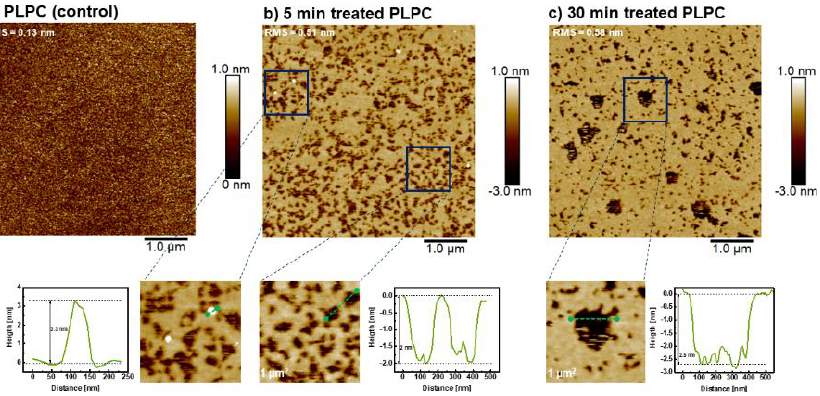
Figure 7. AFM images of supported PLPC bilayers before ( a ), after 5 min; and ( b ) after 30 min; ( c ) plasma treatment. Bottom row: The images are magnifications of the indicated areas. Histograms along the green lines show the height of the protrusions (left), and the increasing depth of the pores with increasing treatment time. Experimental conditions as in Figure 6.